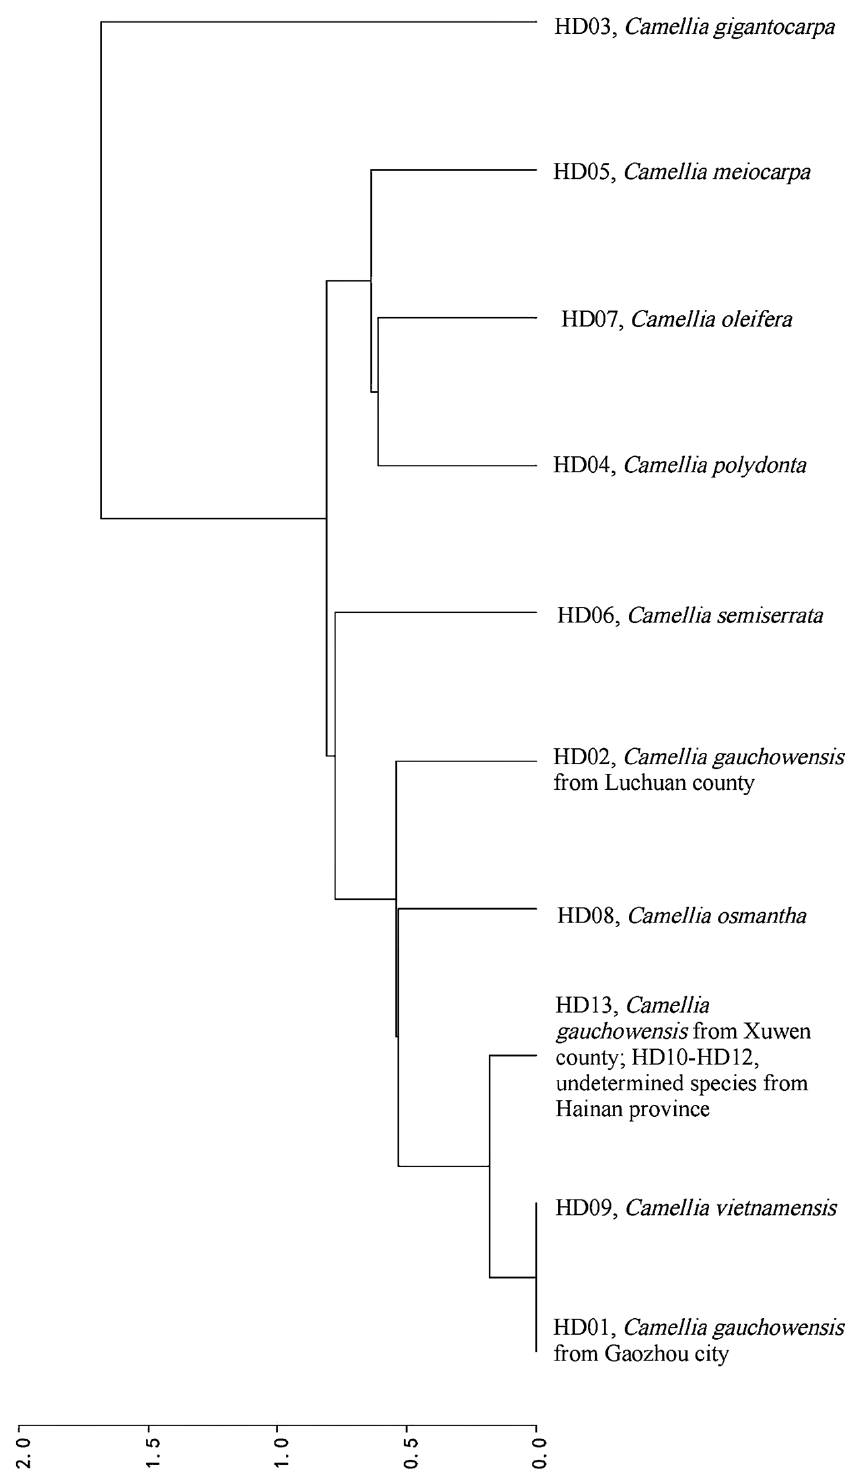
Figure 6. Cluster analysis based on the RSCU of the di ff erent samples.